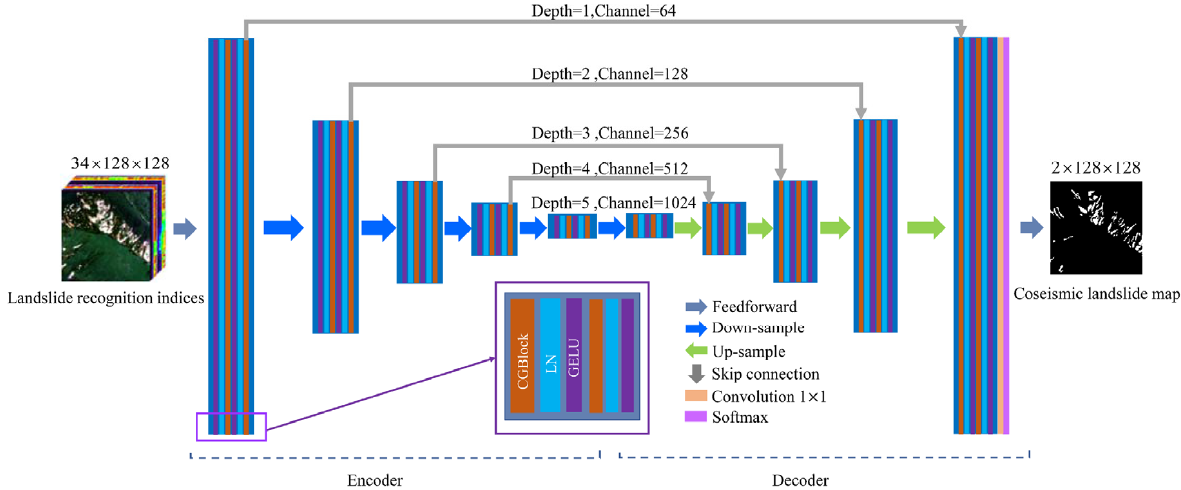
Figure 5. Structure of the EGCN.